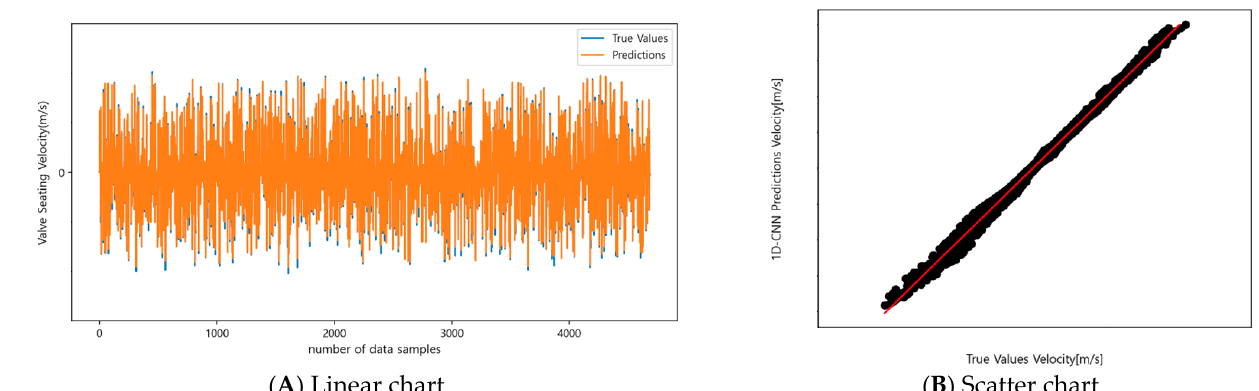
Figure 13. The predicted values of the valve train force using the 1D-CNN model.